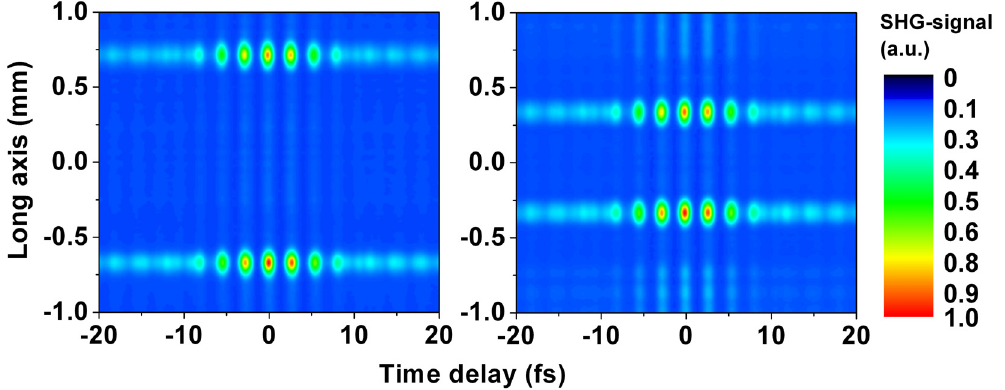
Figure 7. Temporal autocorrelation function of a stadium-shaped few-cycle light bullet at a distance of 80 mm; left : cut through the major (long) axis; right : cut through the minor (short) axis.